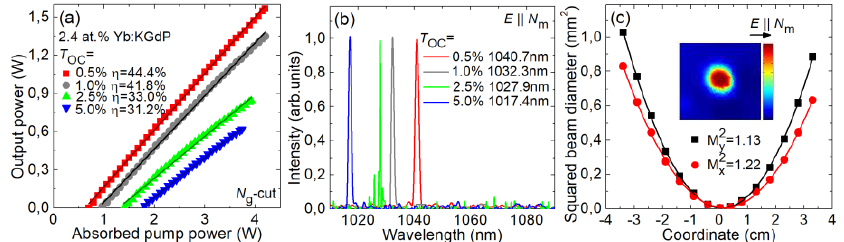
Fig. 2 Diode-pumped 2.4 at.% Yb 3+ :KGd(PO 3 ) 4 (Yb:KGdP) laser: (a) Input-output dependences, η – slope efficiency; (b) typical spectra; (c) evaluation of the beam quality factors, M 2 x,y ; inset : far-field mode profile, T OC = 0.5%, P abs = 3.6 W. The laser polarization is E || N m (horizontal, || x